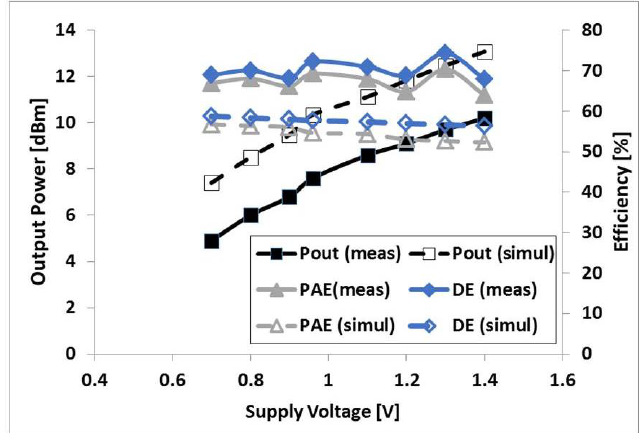
Figure 7. Microphotograph of the implemented power amplifier